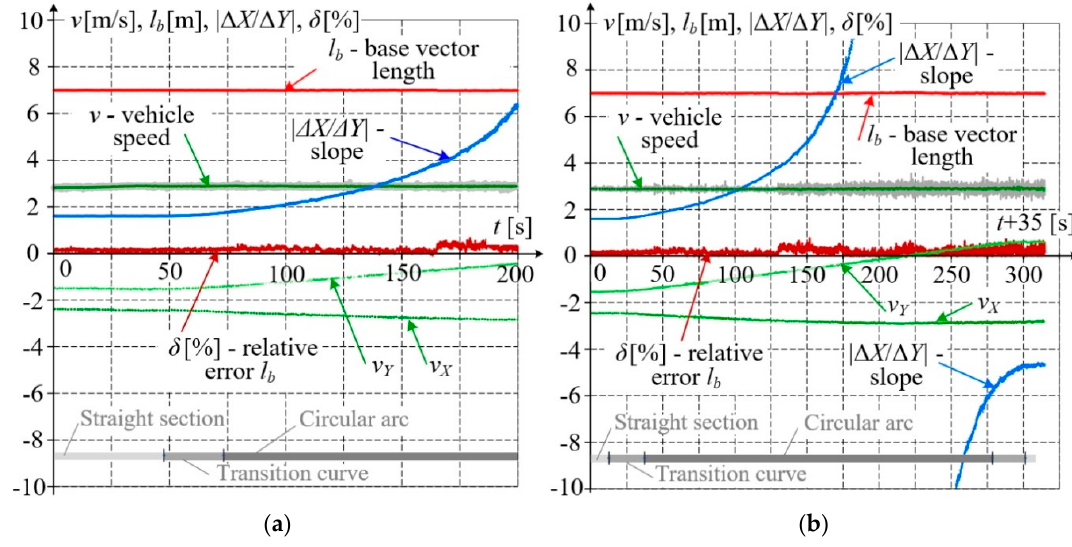
Figure 12. Waveforms of qualitative parameters of multi GNSS measurements: ( a ) straight section of track changing to circular arc; ( b ) section consisting of transition curves and circular arc.